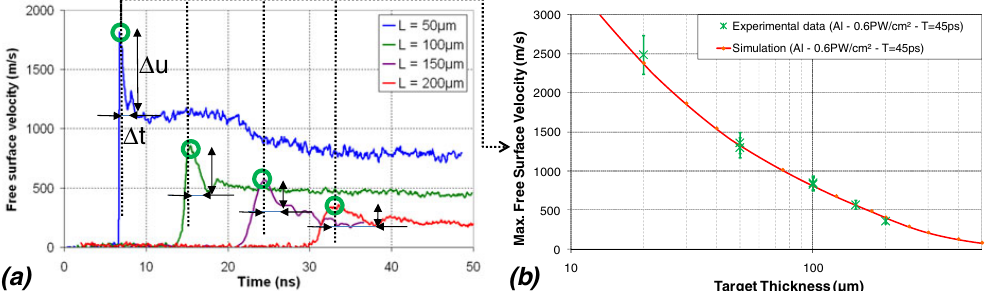
Fig. 2. Experimental free surface velocities of laser shocked aluminium targets of di ff erent thicnesses at the same intensity (2a) ; Experimental / Numerical comparison of the maximum free surface velocities withe target thickness at a 0 . 6PW / cm 2 laser intensity